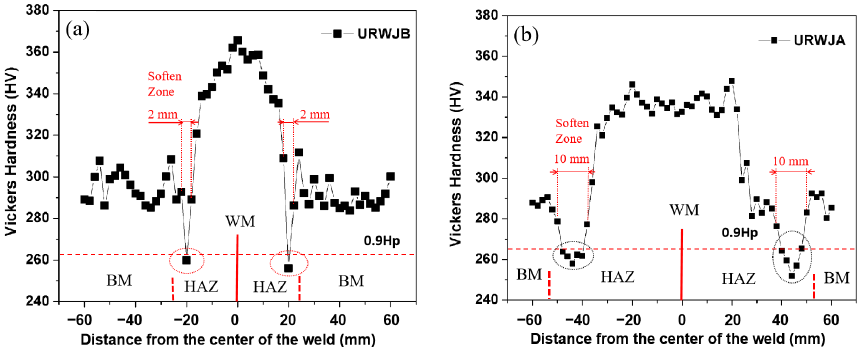
Figure 5. The Vickers hardness of FBW joints: ( a ) URWJB, ( b ) URWJA.